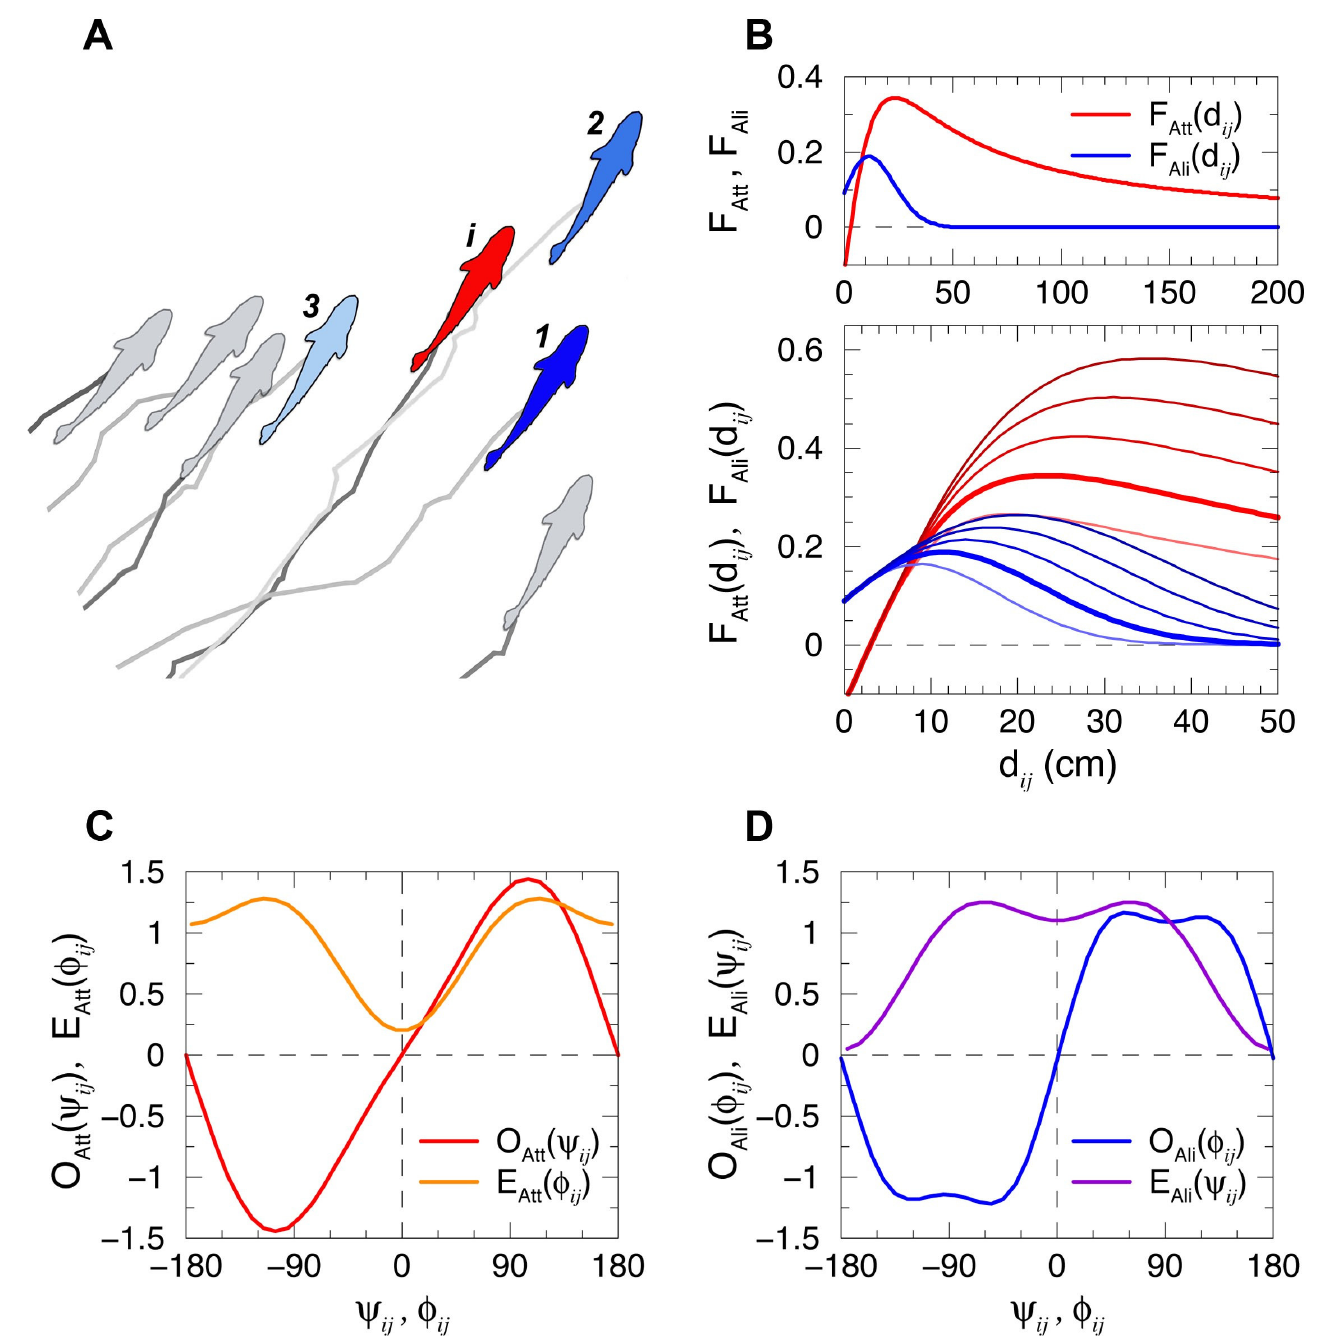
Fig 2. Social influence and interaction functions between fish. (A) Example of simulated fish trajectories for a few time steps highlighting the 3 most influential neighbors of fish i (red) according to their respective influence I as determined by the model, from the most influential (dark blue) to the least influential one (light ij blue). (B) Intensity of the attraction F Att (red) and the alignment F Ali (blue) for different interaction ranges l Att = 0.16, 0.2, 0.24, 0.28 and 0.32 m, and l Ali = 0.16, 0.2, 0.24, 0.28 and 0.32 m, from light to dark color intensity. Wider red and blue lines correspond to the values extracted from the experiments with H. rhodostomus in [44], l Att = l Ali = 0.2 m. The upper subpanel shows the long range of attraction in d 2 [0, 2] m. (CD) Normalized angular functions O Att ( ψ ) (odd, in red) and E Att ( ϕ ) ij ij ij (even, in orange) of the attraction interaction, and O Ali ( ϕ ij ) (odd, in blue) and E Ali ( ψ ij ) (even, in violet) of the alignment interaction between fish i and j , as a function of the angle of perception ψ and the relative heading ϕ ij ij